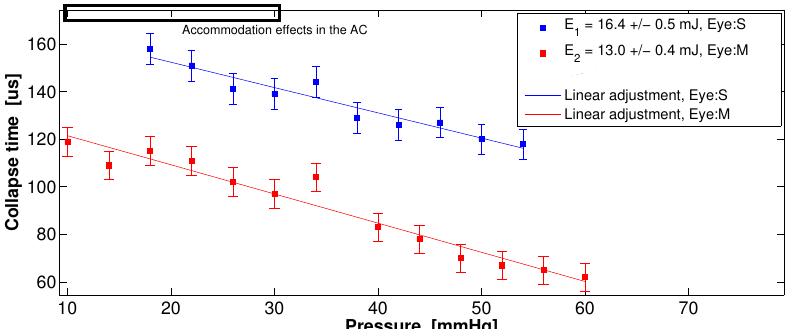
Figure 8. Collapse time vs. external pressure induced into the AC for two ex vivo pig eyes. The slopes m based on the linear adjustment are m (13 mJ) ≈ 1.2 µ s/mmHg and m (16.4 mJ) ≈ 1.05 µ s/mmHg. Each point represents the average of 16 STM signals. The upper rectangle indicates the region of the AE causing a decrease in the depth of the